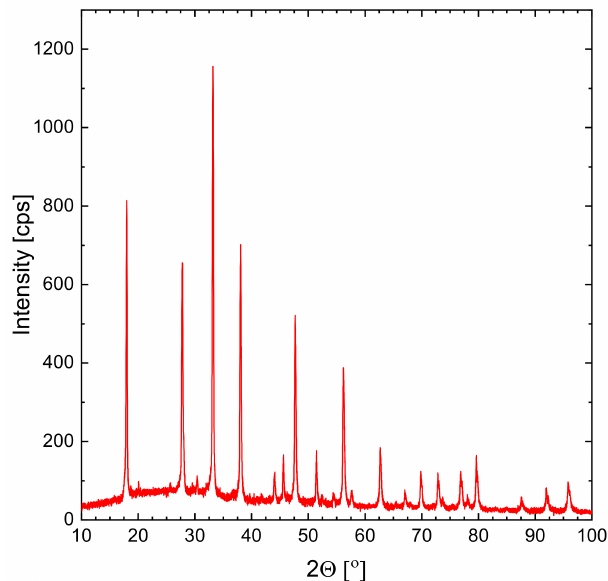
Figure 14. XRD analysis of the obtained materials. The concentration of bismuth and rhenium in the solution was 1 × 10 − 3 M, and the concentration of silver was 1 × 10 − 4 M. The synthesis of nanoparticles was carried out in the presence of a PVA as a stabilizing agent. The database does not contain information on the existence of the Ag–Bi–Re